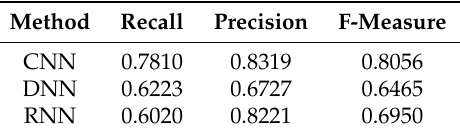
Table 2. Performance on pitch estimation using different neural